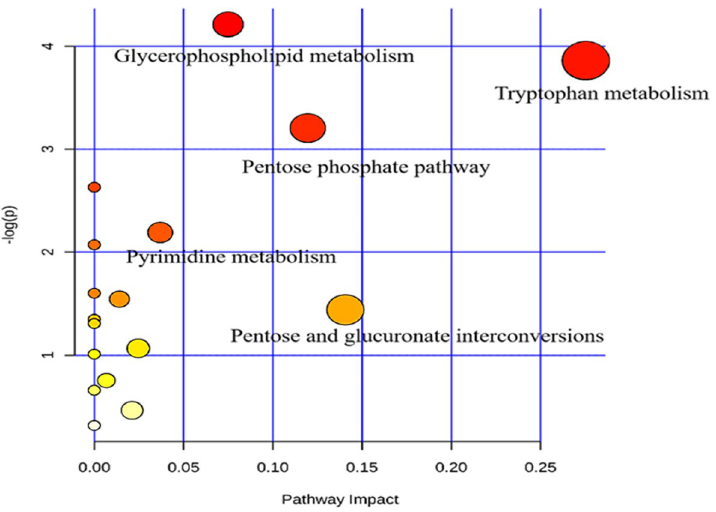
Figure 6. The differential metabolites of plasma involved in main pathways between anxiety comorbidity ACS and ACS